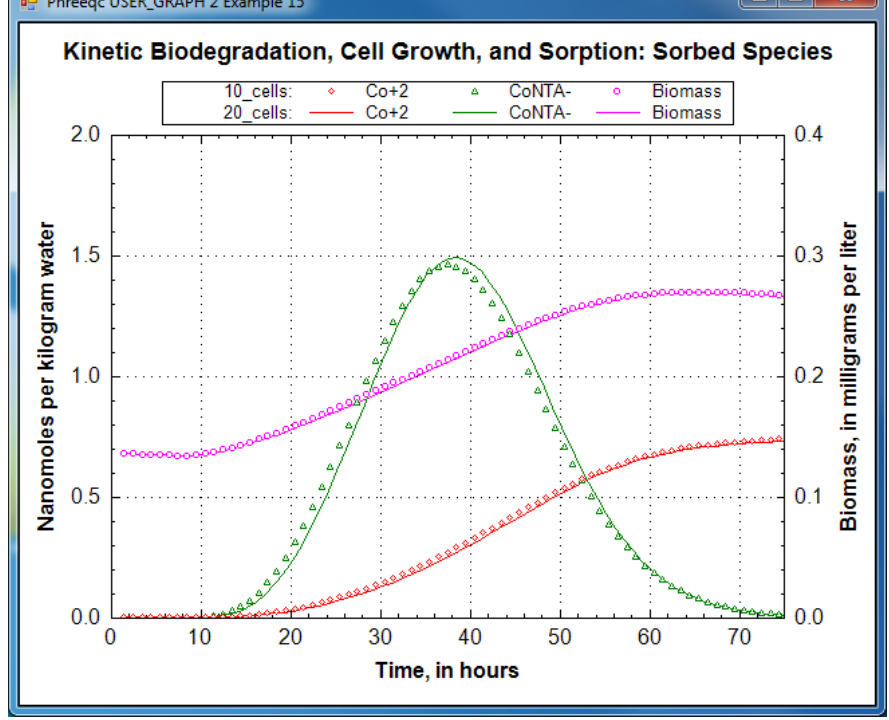
Figure 17. Concentrations of sorbed species and biomass at the outlet of the column for Nta and cobalt transport simulations with 10 (symbols) and 20 cells